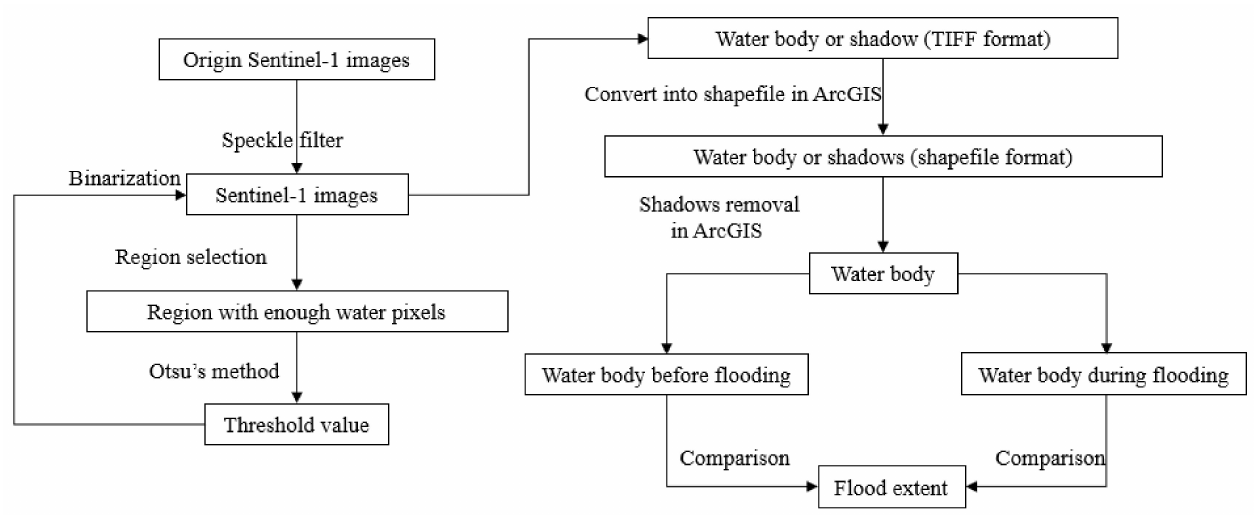
Figure 3. Flowchart of flood monitoring based on Sentinel-1